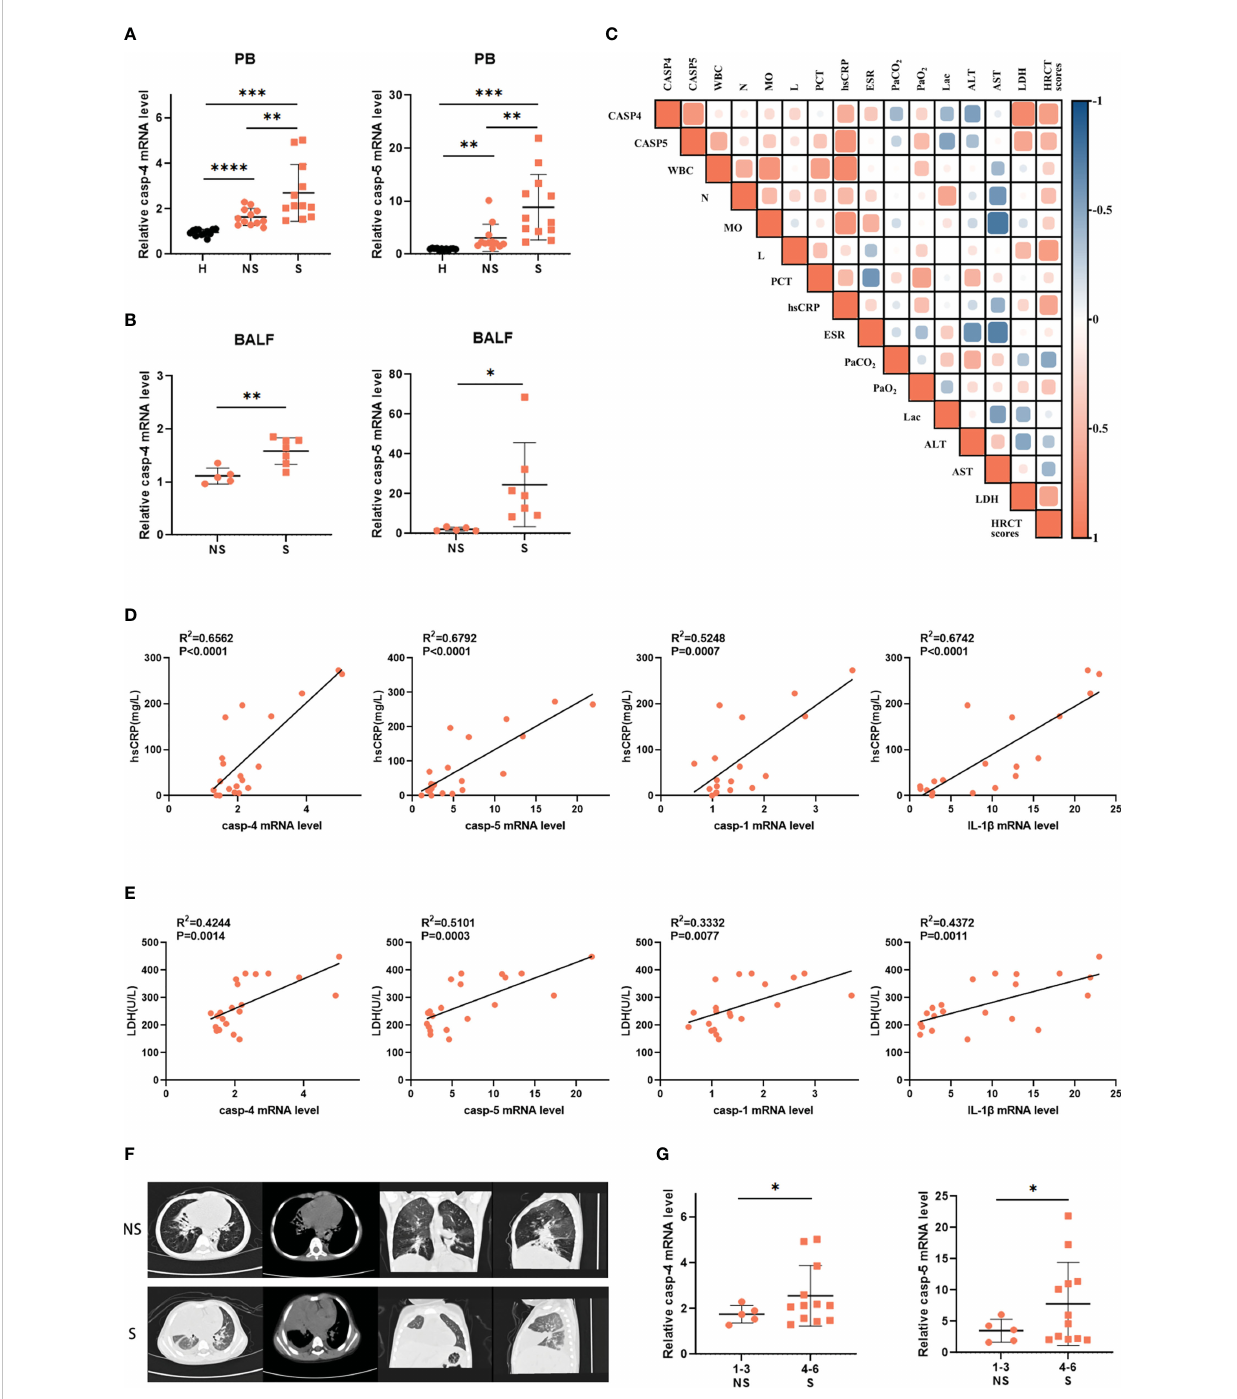
FIGURE 2 Caspase-4 and caspase-5 expression levels were increased and positively correlated with in fl ammatory damage. (A) Expression levels of caspase-4 and caspase-5 in PBMCs isolated from adenovirus pneumonia pediatric patients (12 non-severe vs 12 severe) and healthy volunteers ’ (n=15) peripheral blood samples or (B) in cells isolated from severe (n=7) and non-severe patients (n=5) BALF samples. (C) Correlation matrix of caspase-4 and caspase-5 levels of pediatric patients (n=9) and their clinical parameters. (D, E) Correlations of indicated clinical in fl ammatory parameters of pediatric patients (n=20) with in fl ammation-related genes, respectively. (F) The representative lung HRCT images of severe and non-severe adenovirus pneumonia pediatric patients. (G) Expression levels of caspase-4/5 in adenovirus pneumonia pediatric patients (n=17) divided into two groups according to the HRCT scores. Data are representative of at least three experiments. Error bars represent the mean ± SEM. * P value<0.05, ** P value <0.01, *** P value <0.001, **** P value <0.0001, ns, no signi fi